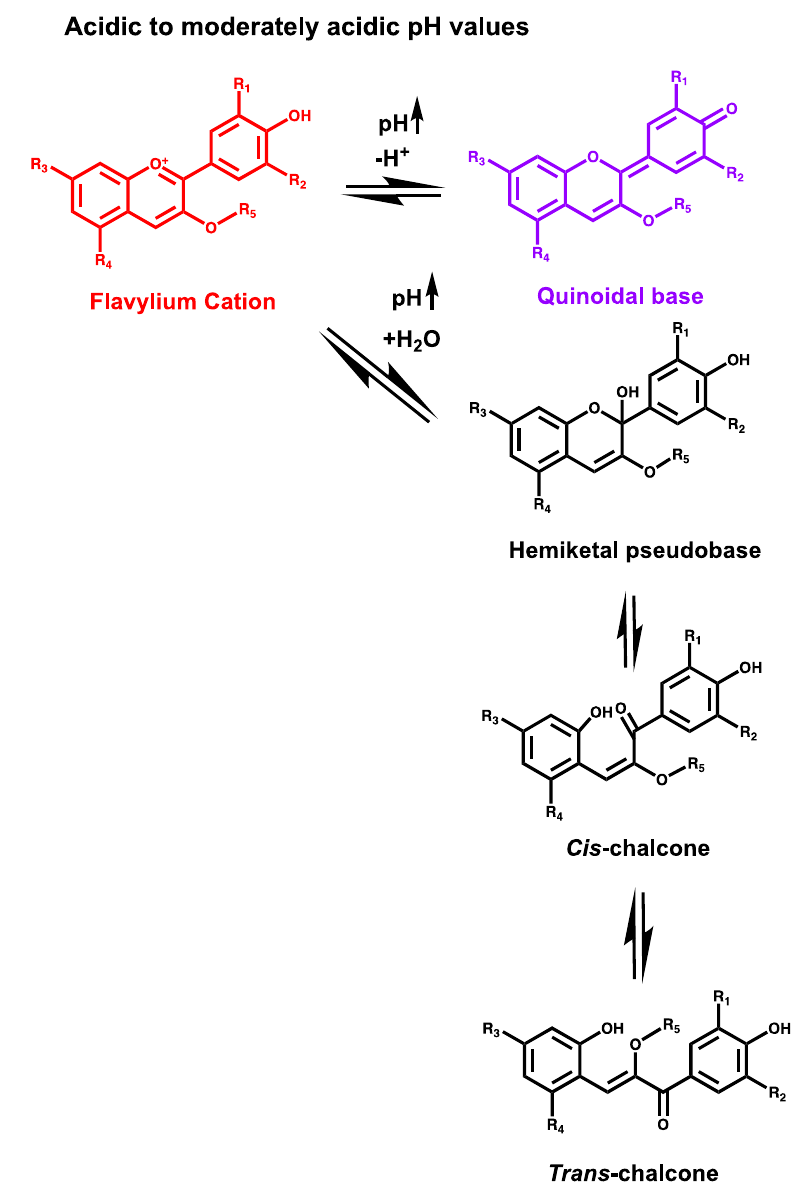
Figure 2. Dynamic equilibrium network of anthocyanins at di ff erent pH values. R 1 = H, OH or OCH 3 ; R 2 = H, OH or OCH 3 ; R 3 = OH or sugar moiety; R 4 = OH or sugar moiety; R 5 = sugar moiety. The sugar moiety of anthocyanins can be composed by di ff erent attached